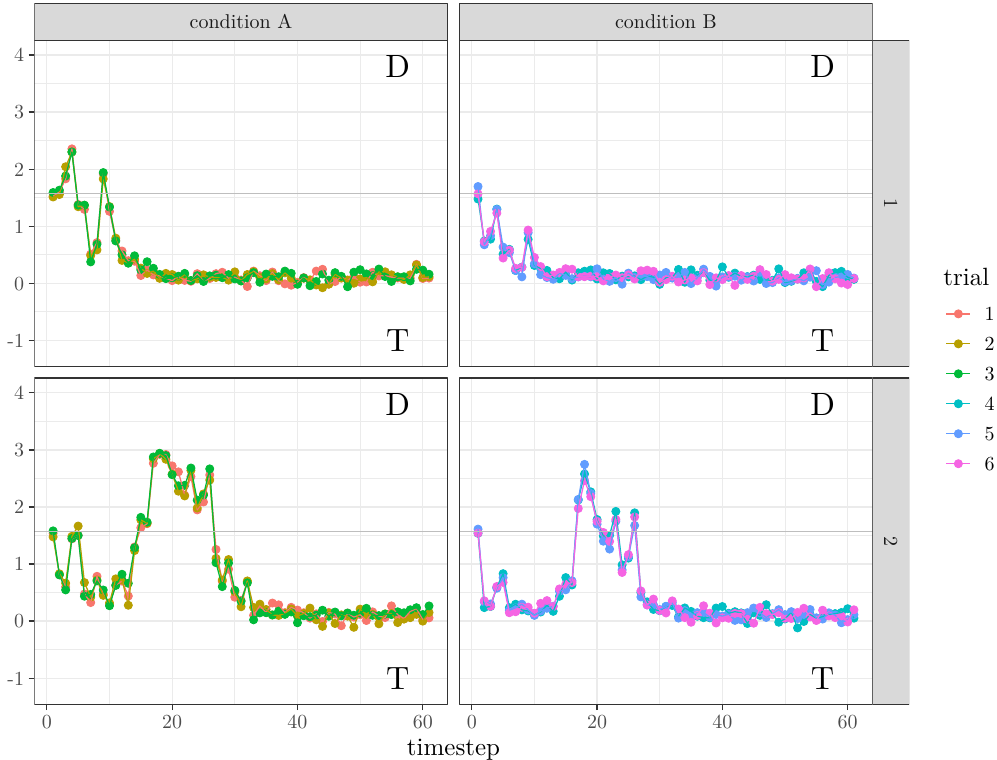
Figure 2. Simulated mouse-tracking trajectories Y plotted over time step n = 1, . . . , N . The data refer to a univariate design with I = 2 (rows of the plot), K = 2 (columns of the plot) and J = 6 (colors of the plot). Note that each of the K levels has J / K trials, T and D indicate Target and Distractor sections of the movement